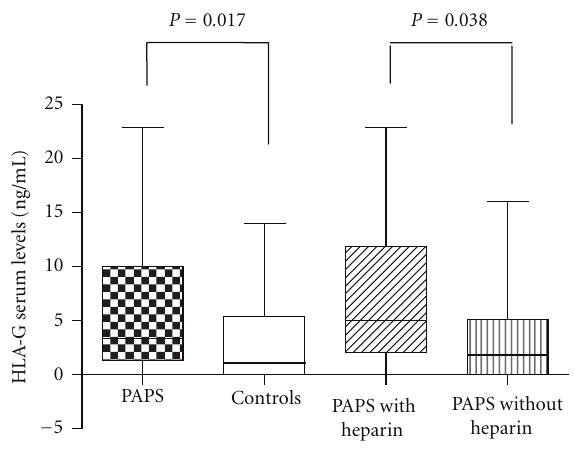
Figure 1: HLA-G serum levels in 44 PAPS patients and 43 healthy controls, and in PAPS patients with and without